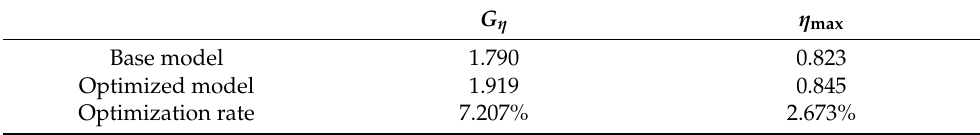
Table 7. Comparison of objectives between the base and optimized models.